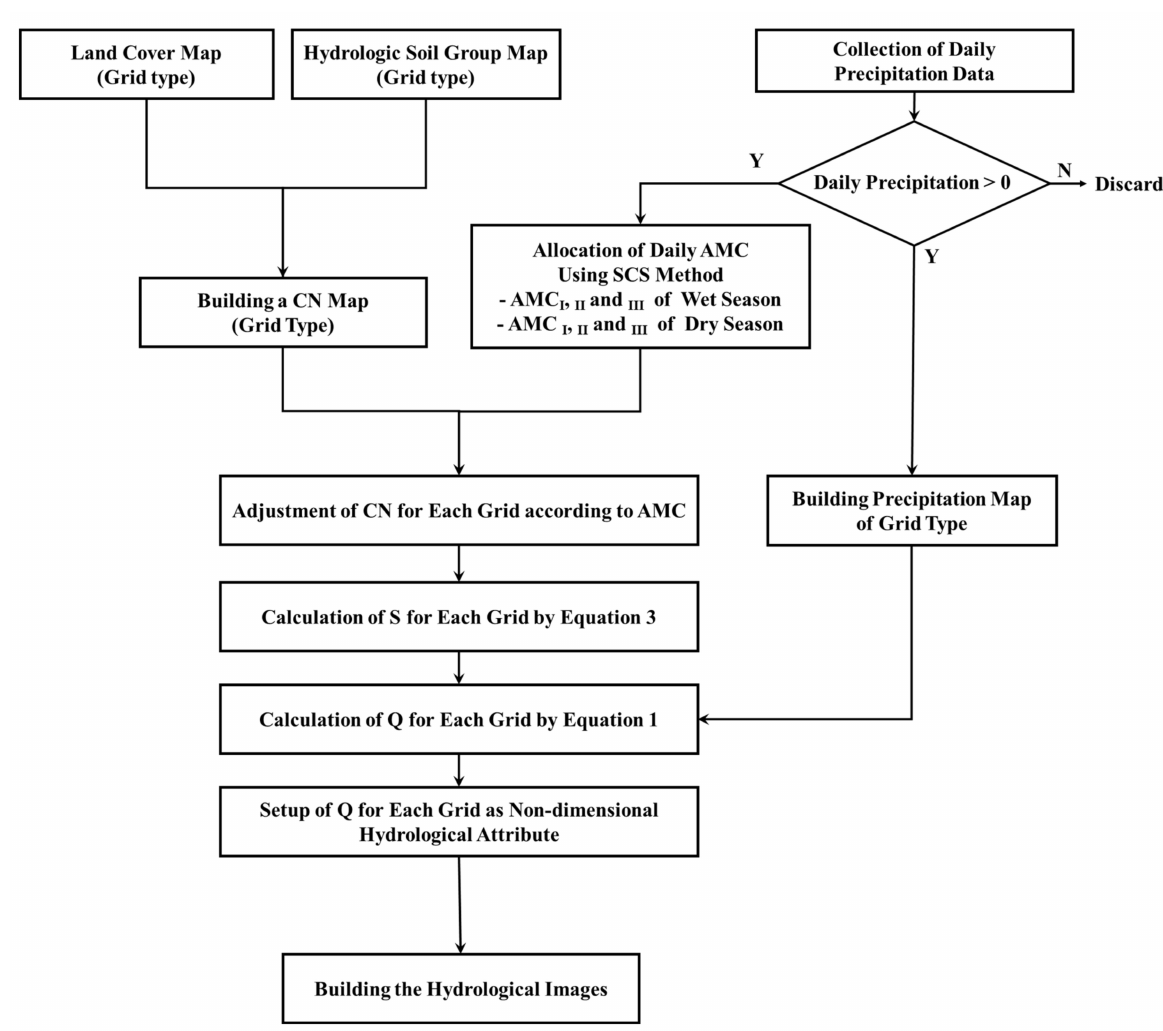
Figure 6. Schematic for the building process of a hydrological